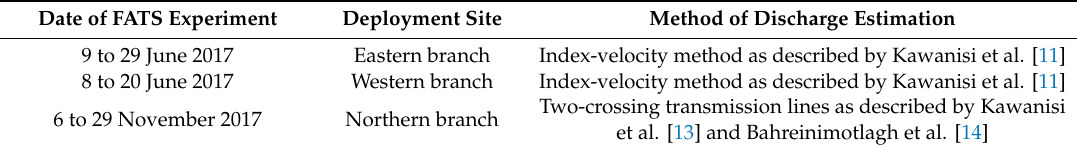
Table 1. Summary of the fluvial acoustic tomography system (FATS) experiment period.